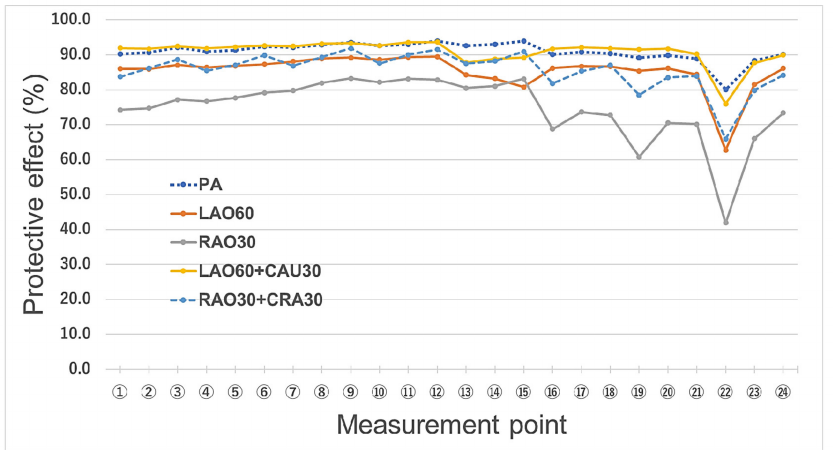
1 MP: Measurement point. 2 Without: Doses measured without the novel radiation shield (The average of three measurements was recorded). 3 With: Doses measured with the novel radiation shield (The average of three measurements was recorded). 4 PE : Protective effect, (D without − D with )/D without × 100%.